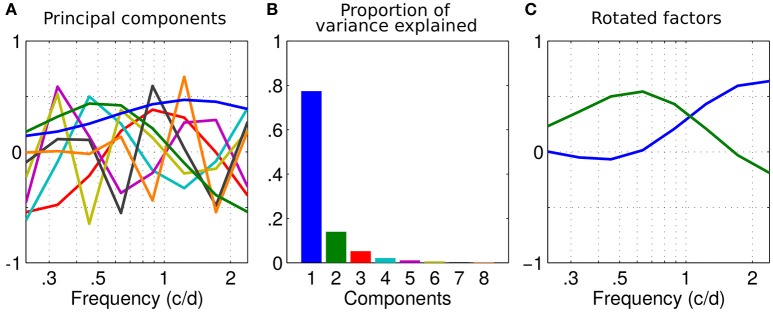
Factor analysis. (A) Principal components of the dataset as a function of spatial frequency. Their order is indicated by colors in (B). (B) Scree plot of the variance explained by each component of the principal component analysis (PCA) in (A). (C) First two components rotated using a varimax rotation.